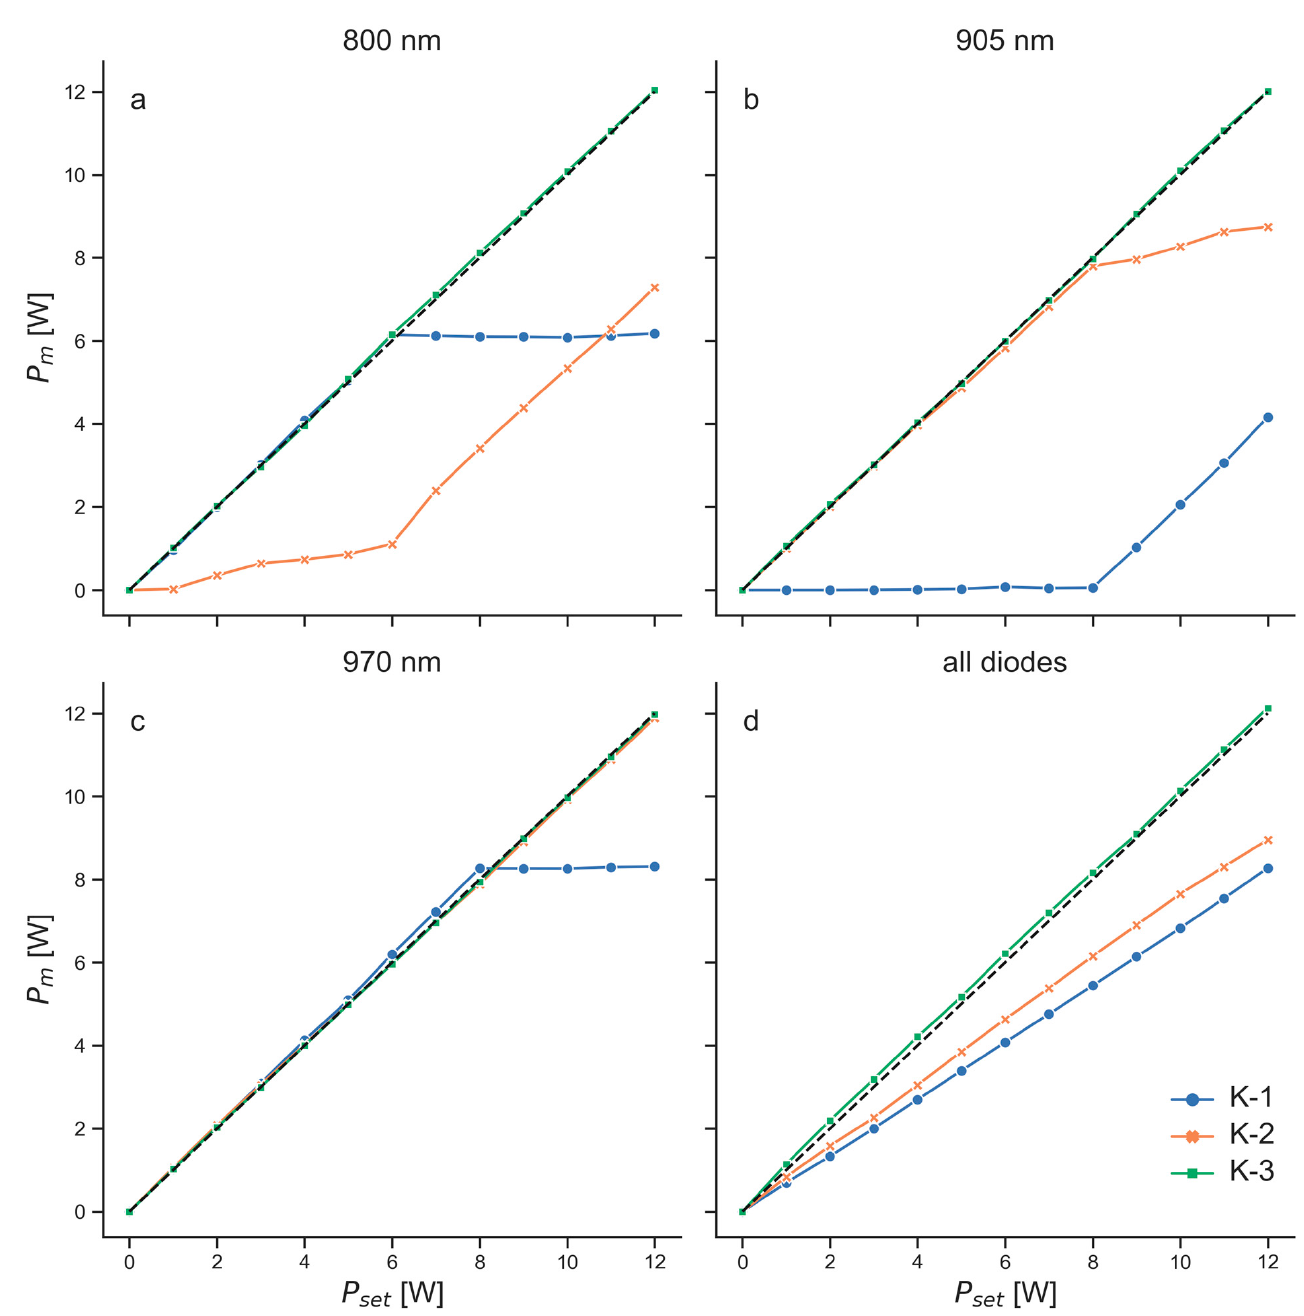
Figure 4. Power measurements of the three K-lasers (K-1, blue dots and blue lines; K-2, orange dots and orange lines; K-3, green dots and green lines) used as continuous wave (CW) lasers. Measured power ( P m ) for different powers set at the devices ( P set ). ( a – c ) Measurements using the three wavelengths (800 nm, 905 nm, 970 nm) individually; ( d ) measurements using all diodes simultaneously. Black dashed lines illustrate ideal curves where P m equals P set .